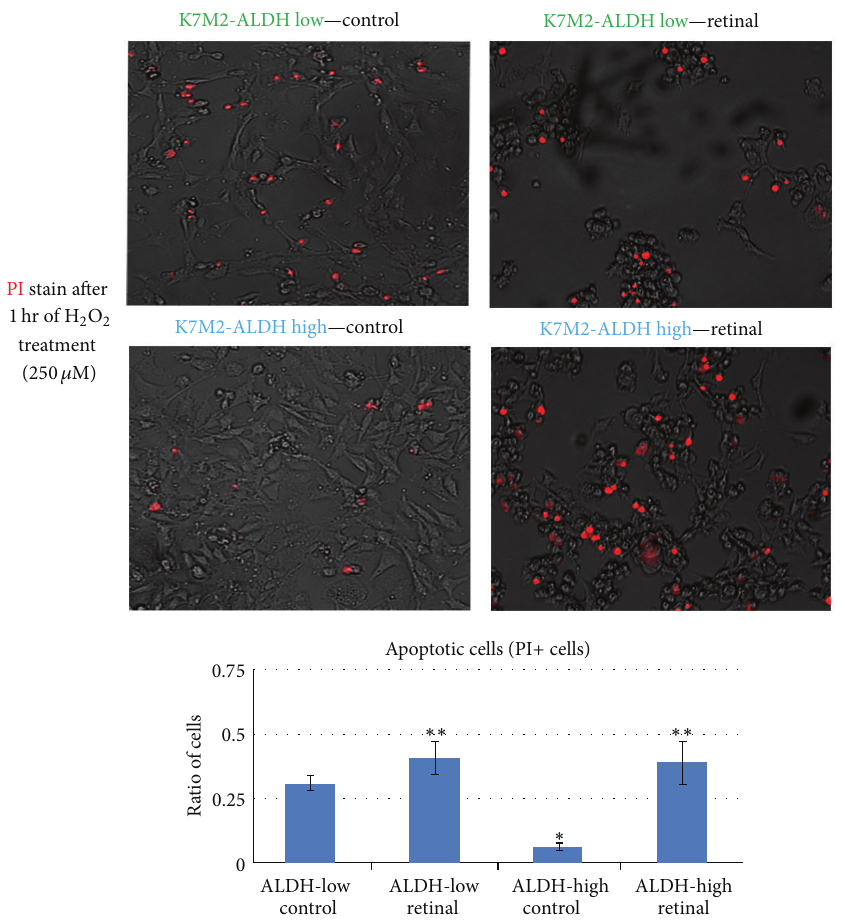
Figure 2: Retinal treatment of sorted ALDH-high K7M2 cells decreased antioxidative stress capacity. After cell sorting according to ALDH activity, it showed that the K7M2-ALDH high cells were more resistant to oxidative stress (H 2 O 2 , 250 𝜇 M for 1hr) than the K7M2-ALDH low cells, while the retinal treatment of K7M2-ALDH high cells was able to greatly decrease their resistance to oxidative stress and resulted in more cell apoptosis. “ ∗ ” indicates that ALDH-high control cells are significant different ( 𝑝 < 0.05 ) compared to ALDH-low control cells; “ ∗∗ ” indicates retinal treated ALDH-high or ALDH-low cells are significant different ( 𝑝 < 0.05 ) compared to nontreated ALDH-high or ALDH-low control cells,